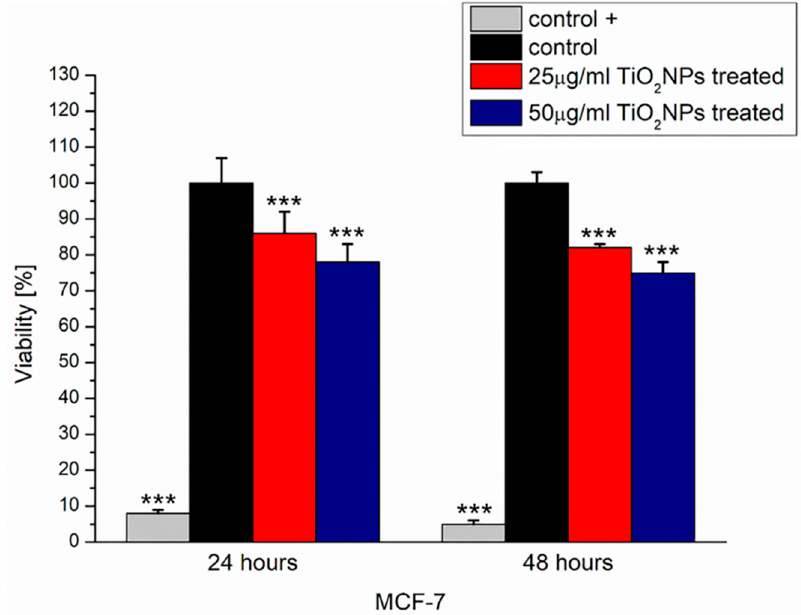
Figure 3. Viability assay (WST-8) on MCF-7 cells after 24 and 48 h TiO 2 NP exposure at two concentrations (25 and 50 µg/mL). Viability of TiO 2 NP-treated cells was normalized to non-treated control cells. As a positive control (control +), cells were incubated with 5% DMSO. Data reported were calculated as average ± SD on three independent experiments, and the statistical significance respect to the control was represented (*** p -value < 0.005).